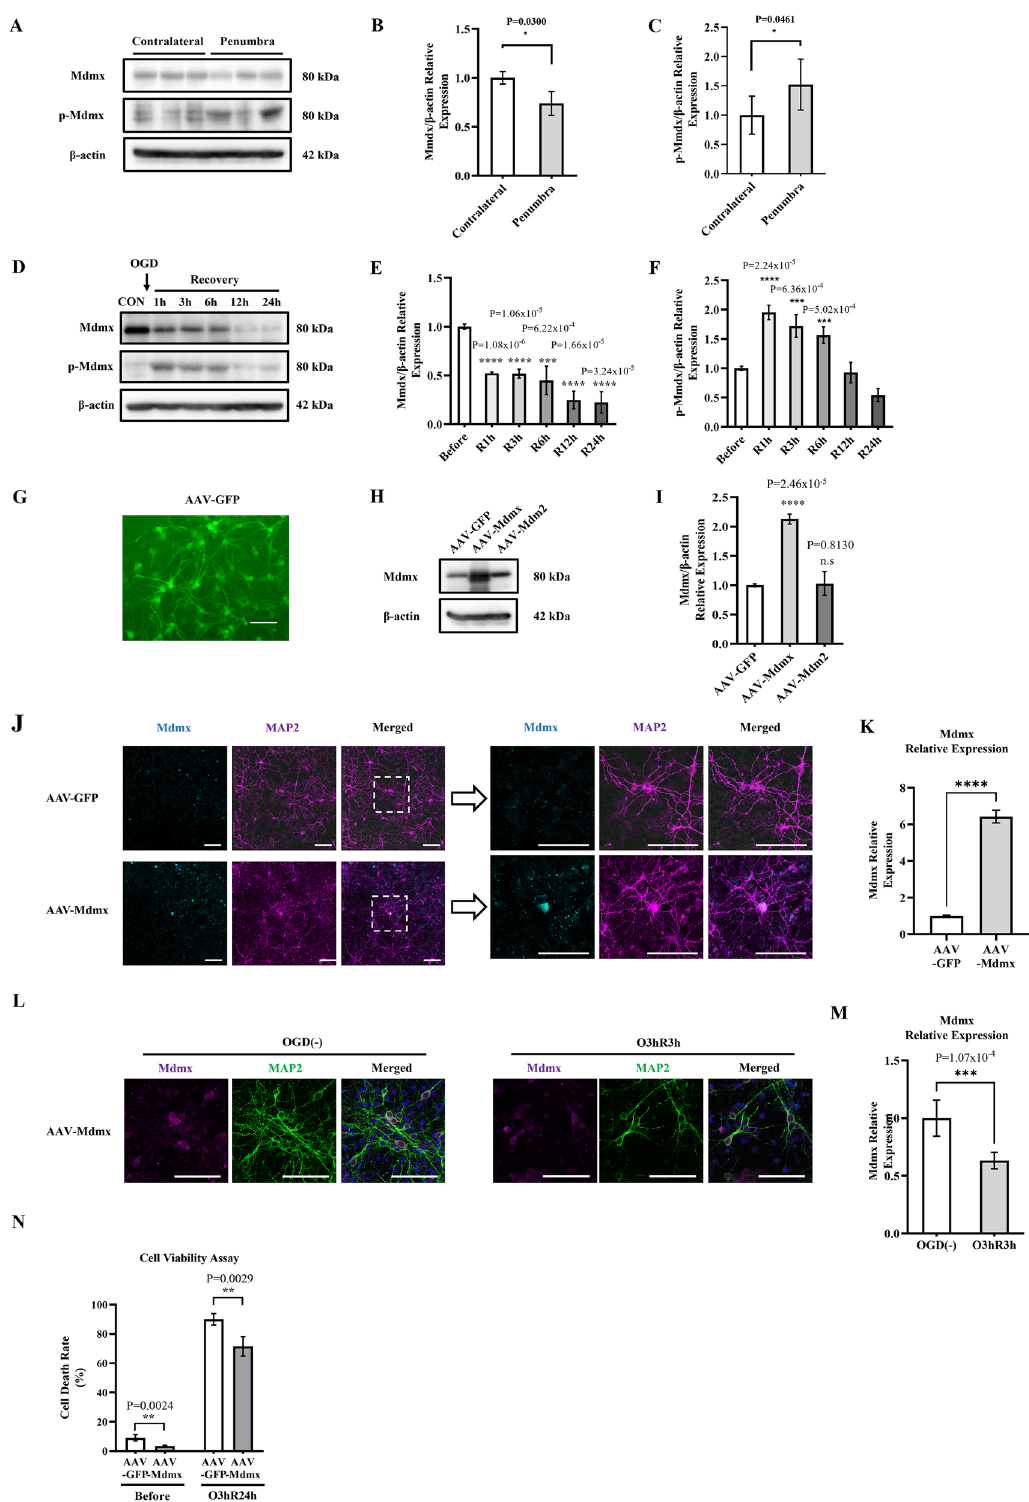
Figure 1. Mdmx exerts a neuroprotective role in hypoxia/recovery. ( A – C ) Western blot ( A ) and quantification of Mdmx ( B ) and p-Mdmx ( C ) in mice contralateral and penumbra. ( D – F ) Western blot ( D ) and quantification of Mdmx ( E ) and p-Mdmx ( F ) in neurons, before and after hypoxia/recovery. N = 3. ( G ) Successful cell transduction is demonstrated by expression of AAV-GFP. Scale Bar = 100 μm. ( H , I ) Western blot ( H ) and quantification of Mdmx ( I ) in AAV-GFP, AAV-Mdmx and AAV-Mdm2 transduced neurons. N = 3. ( J , K ) Immunofluorescence Stanning ( J ) and quantification ( K ) of Mdmx/MAP2 in AAV-GFP and AAV-Mdmx transduced neurons. N = 6. Scale Bar = 100 μm. ( L , M ) Immunofluorescence Stanning ( L ) and quantification ( M ) of Mdmx/MAP2 in AAV-Mdmx transduced neurons, before and after OGD. N = 6. Scale Bar = 100 μm. ( N ) Cell Viability Assay of AAV-GFP and AAV-Mdmx transduced neurons before and after hypoxia/recovery. N =